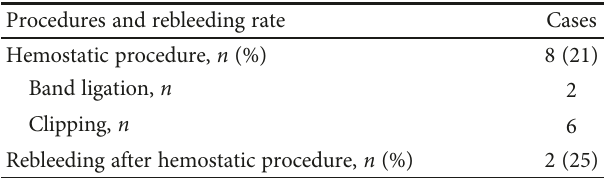
Table 3: Endoscopic hemostatic